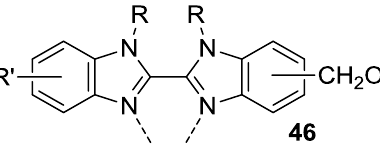
Figure 37. Benzimidazole ligand tested by Swetha et al.